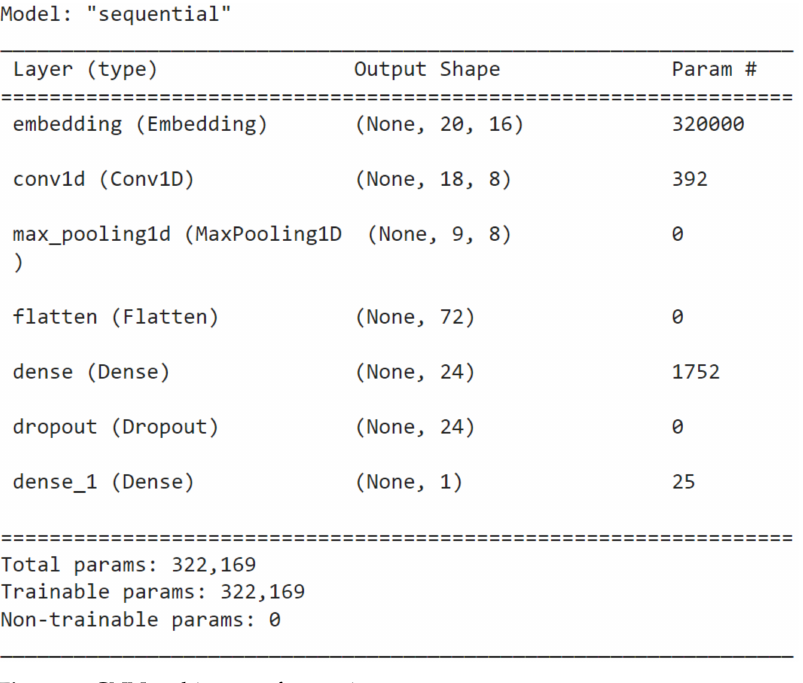
Figure 7. CNN architecture for sentiment.